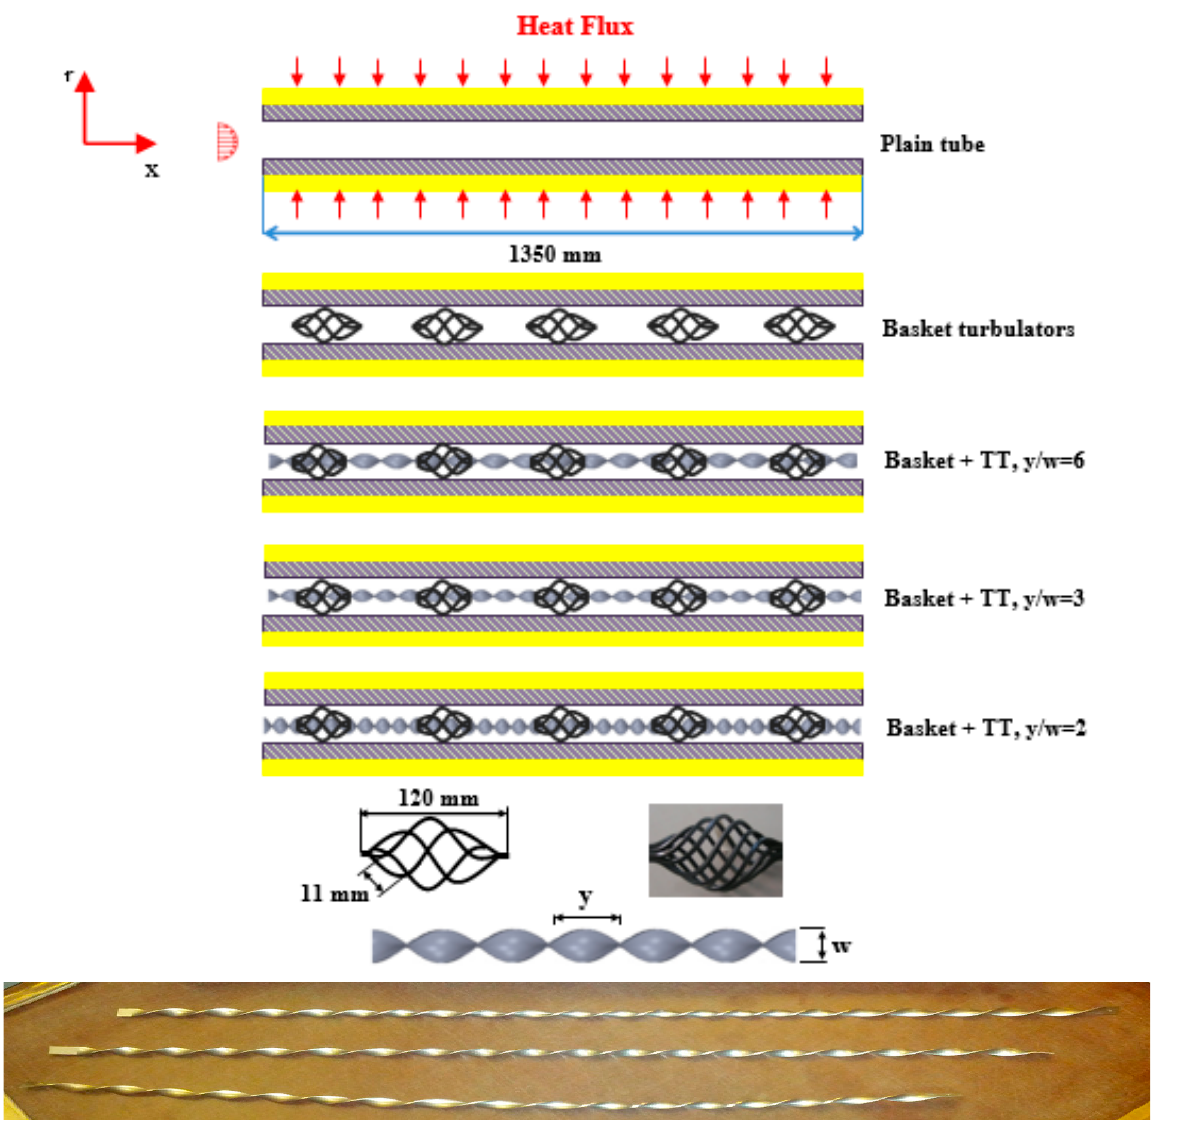
Figure 2. Schematic of the using experimental apparatus.